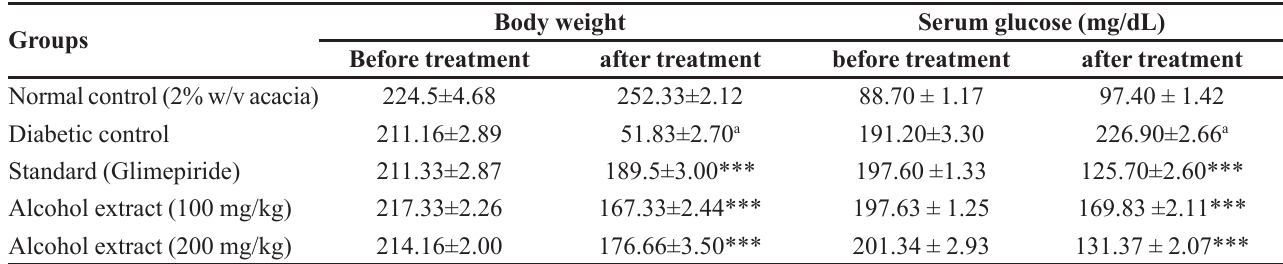
TABLE I - Effect of alcohol extract of W. volubilis root on body weight and serum glucose in Wistar rats Groups